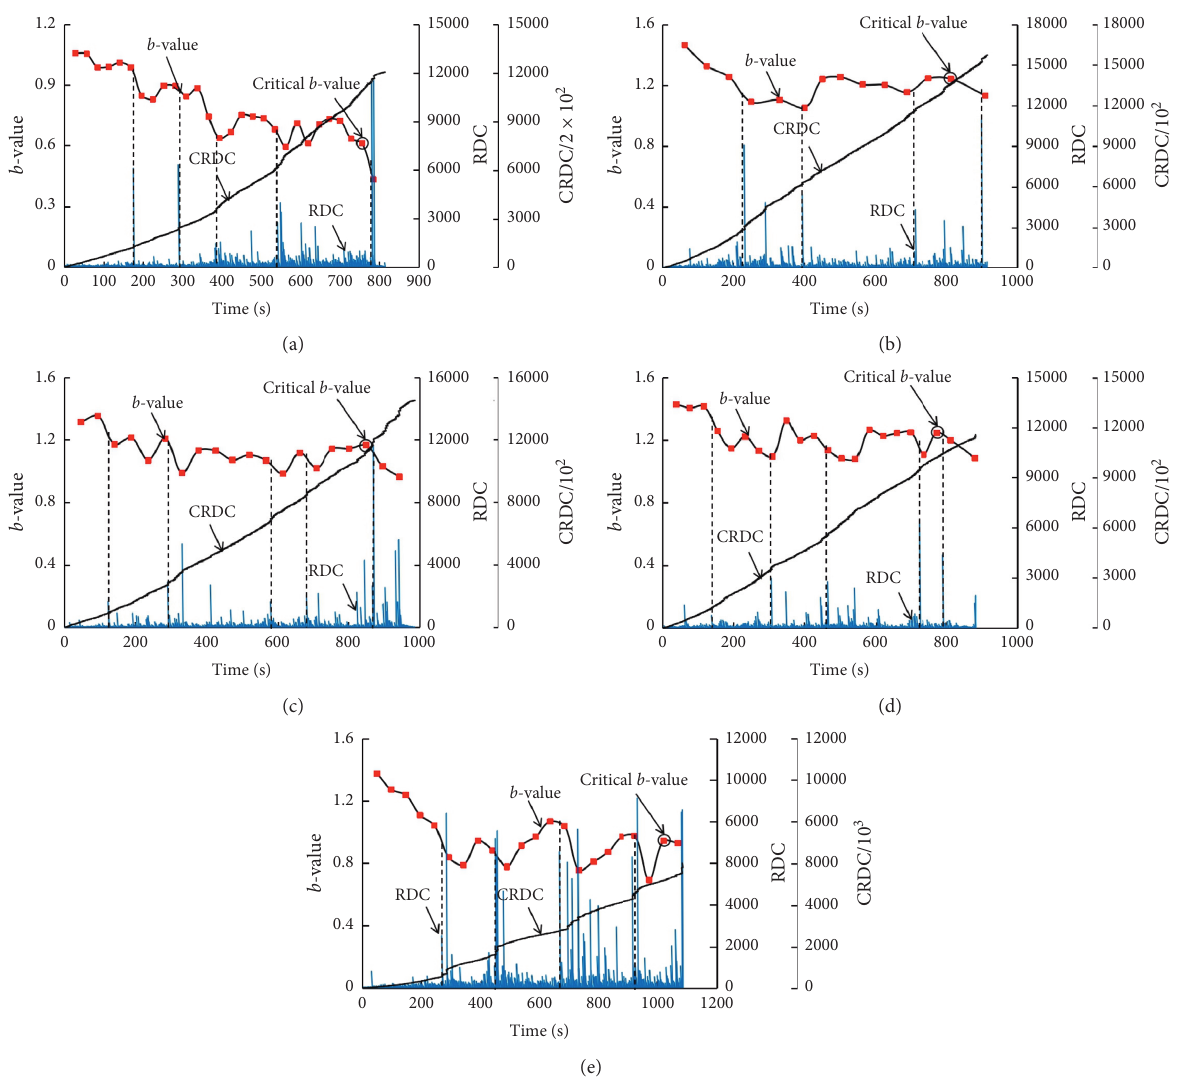
Figure 5: The evolutions of b -value, ring-down count, and cumulative ring-down count of AE with time for the specimens with orthogonal